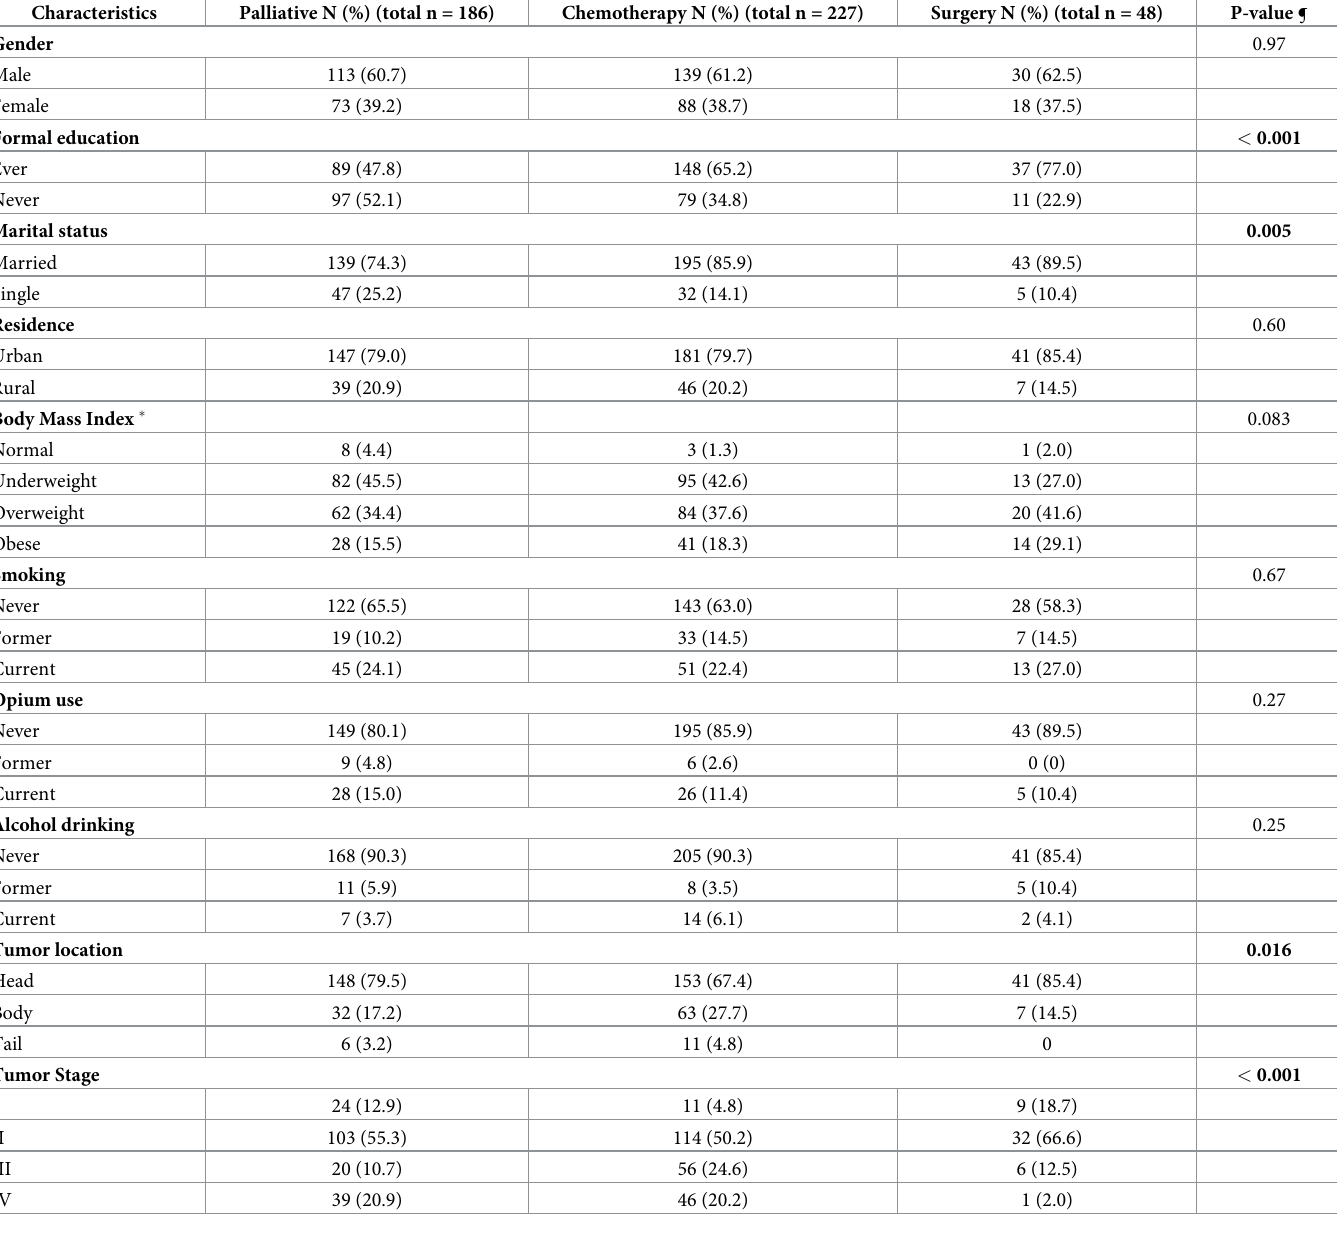
Table 4. Associations between different demographics and tumor characteristics with the type of received treatment among Iranian patients with pancreatic ductal adenocarcinoma.